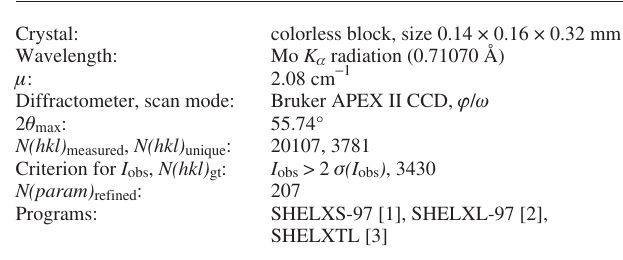
Table 1. Data collection and handling.